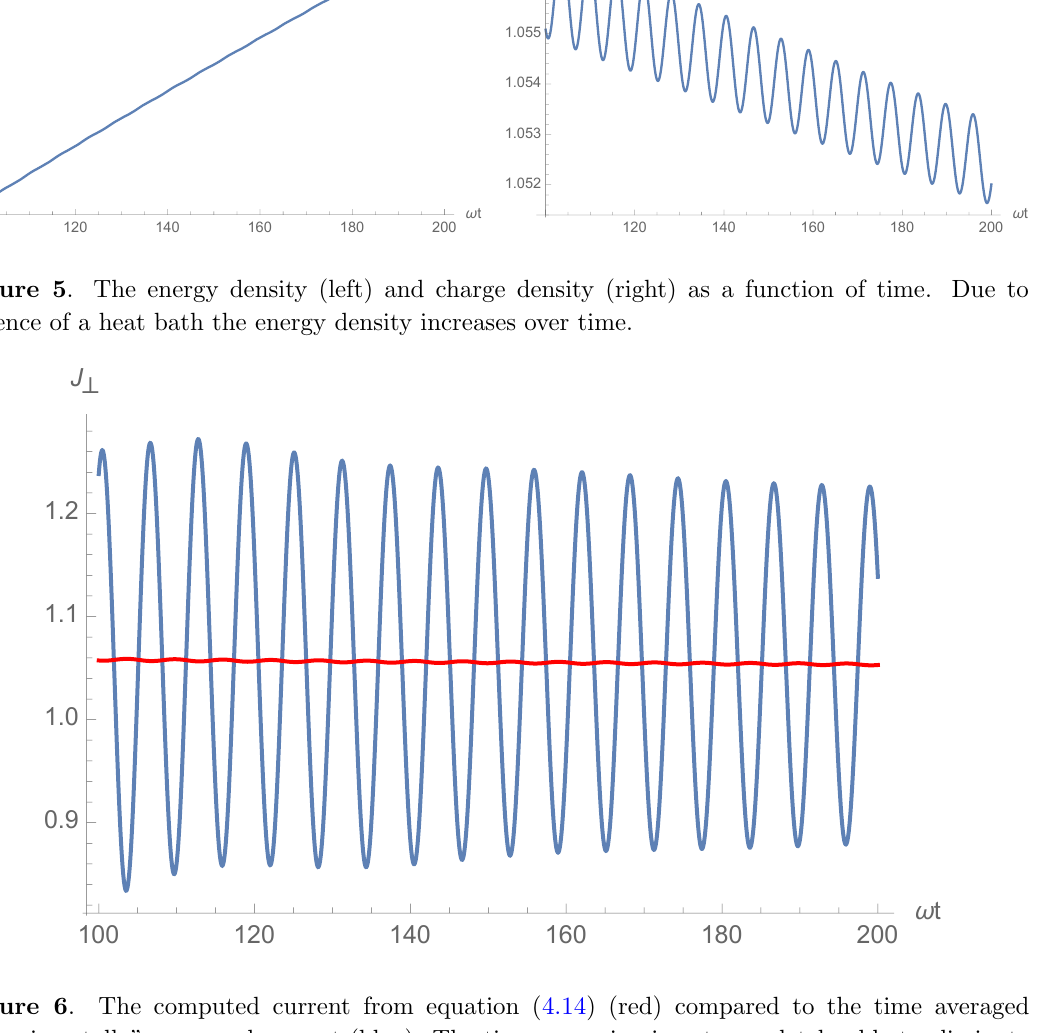
Figure 6 . The computed current from equation (4.14) (red) compared to the time averaged \experimentally" measured current (blue). The time averaging is not completely able to eliminate the periodicity of the current, but the matching appears to be